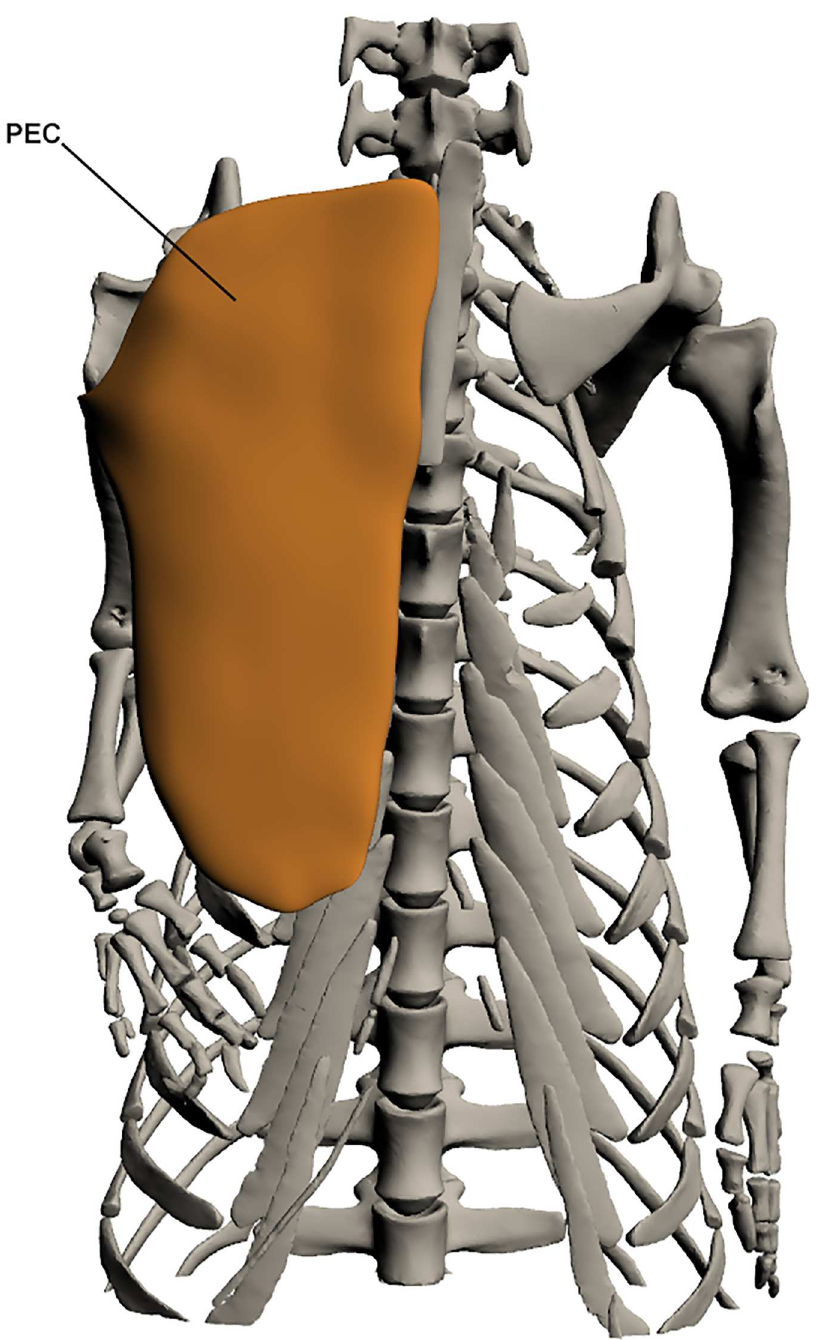
Fig 6. Superficial extrinsic muscles of the forelimb. PEC: Pectoralis .